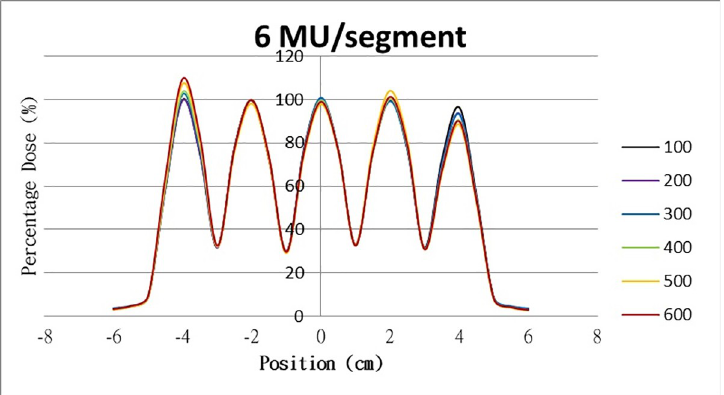
Fig 11. Overshoot effect measured at various MU values and dose rates. Overshoot effect, at various dose rates, for (6) 1 MU, (7) 2 MU, (8) 3 MU, (9) 4 MU, (10) 5 MU, (11) 6 MU, (12) 7 MU, (13) 8 MU, (14) 9 MU, (15) and 10 MU.